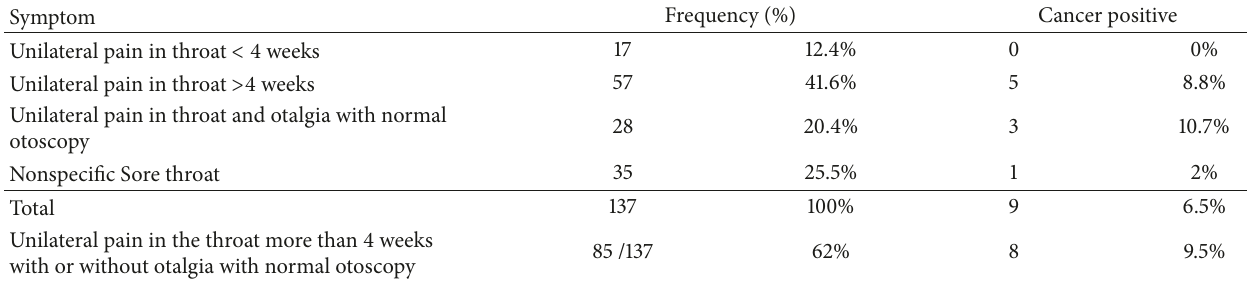
Table 5: Analysis of a persistent sore